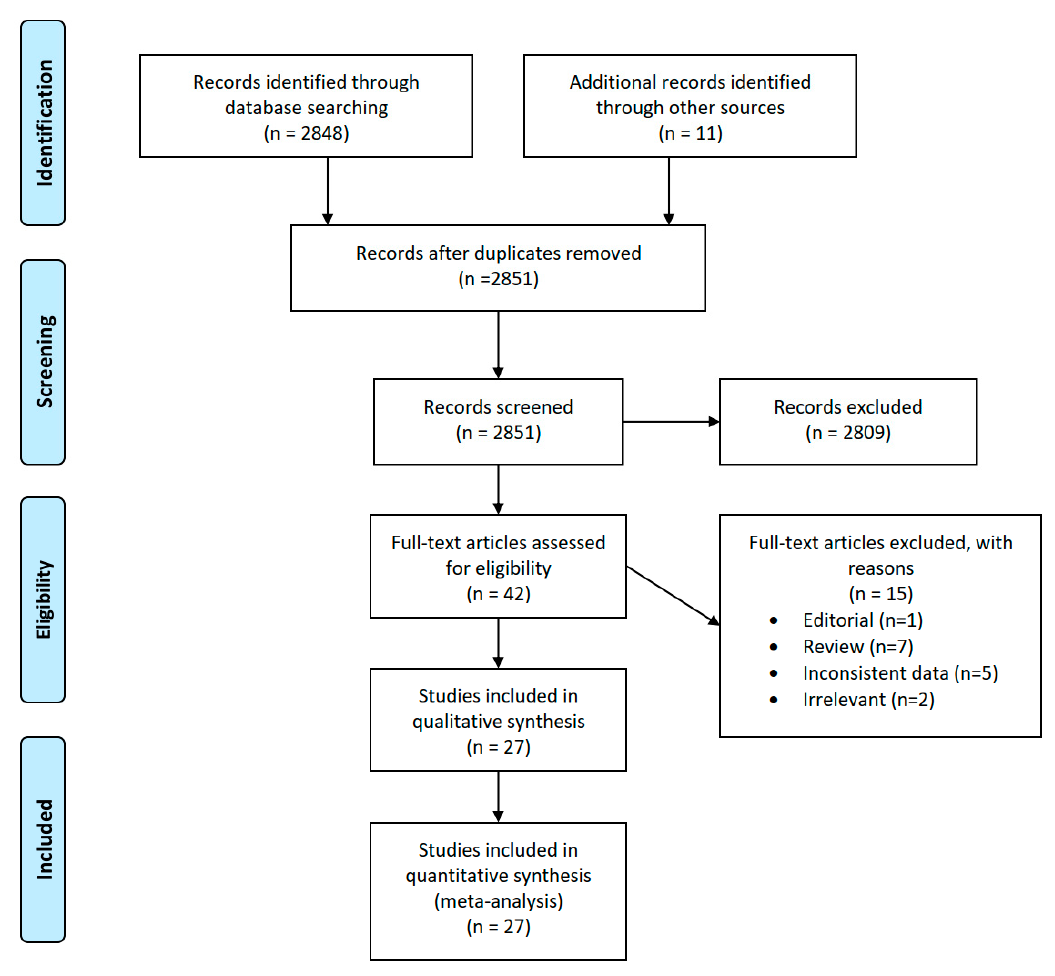
Figure 1. PRISMA flow chart of literature search.